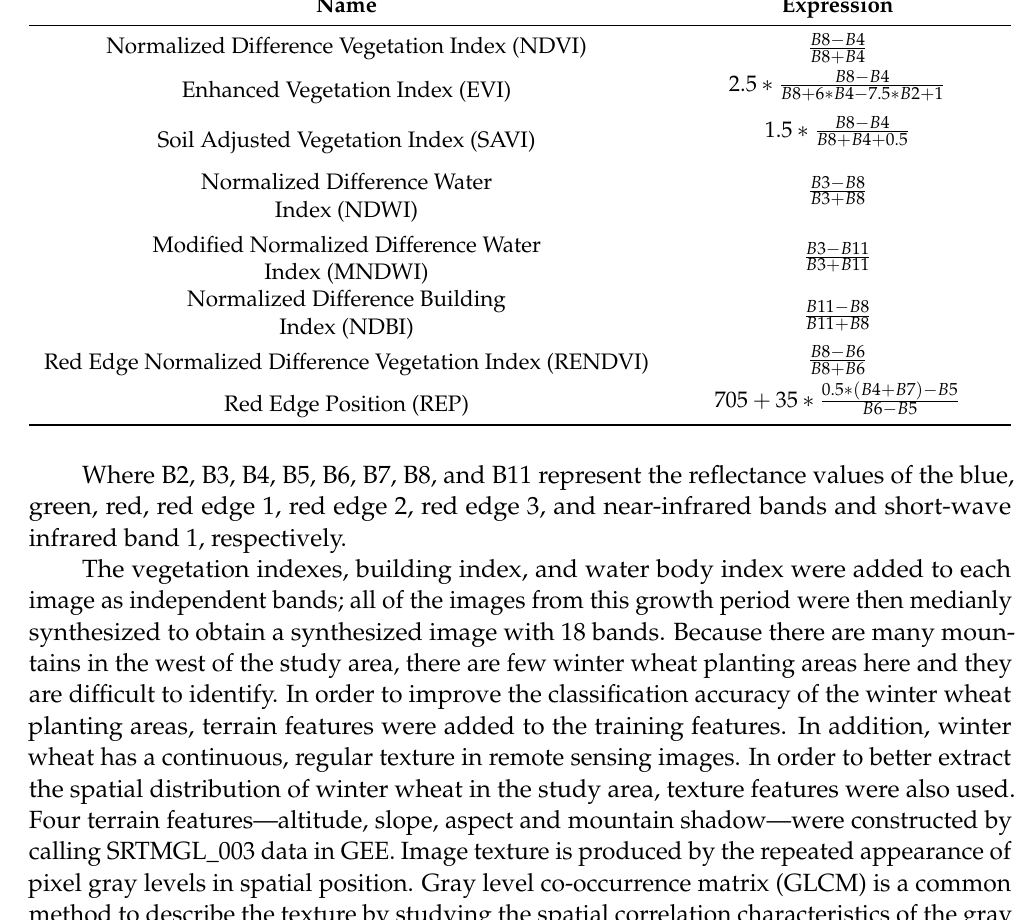
Table 3. Description of spectral features.